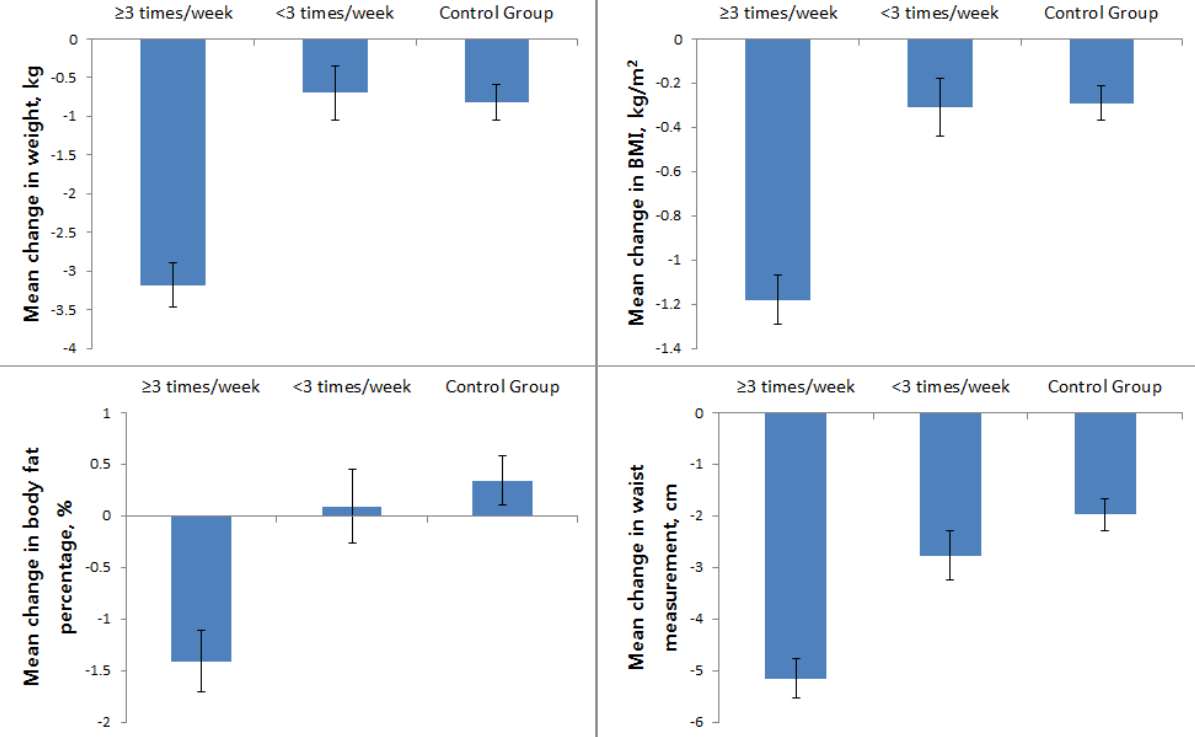
Figure 4. Changes in anthropometric data during the 24-week period analyzed according to weekly mean number of anthropometric measurements. Error bars indicate standard deviation. BMI: body mass